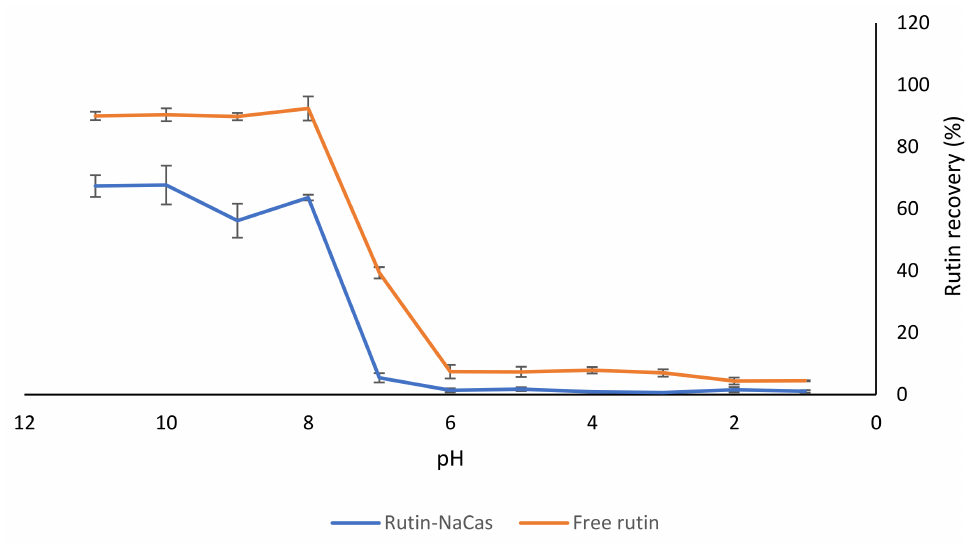
Figure 4. The effect of NaCas on the recovery of rutin from the NaCas–rutin mixture (1%). The results are means of three replicates of